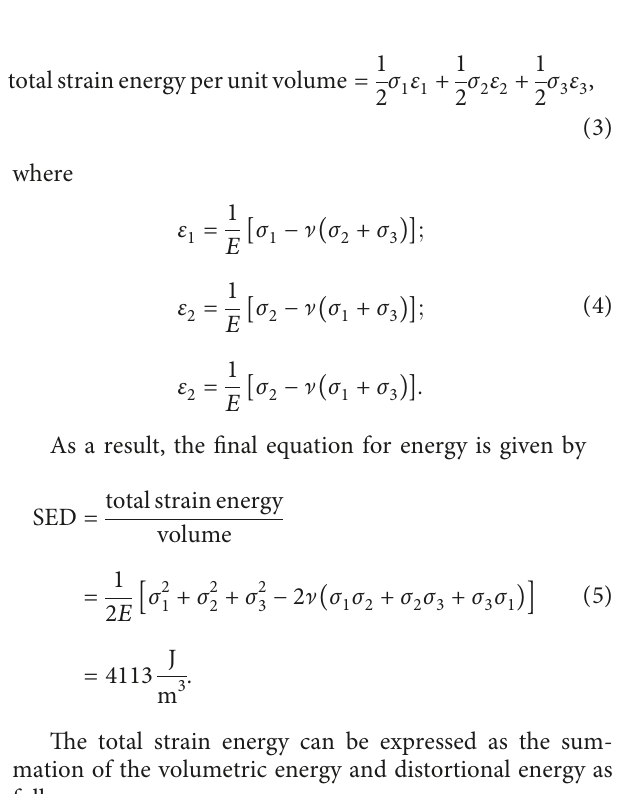
Figure 9: Strain energy density: (a) field and location of maximum SED and (b) variation of SED within the height of the